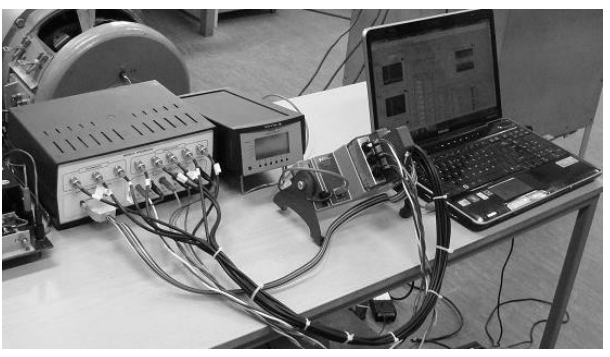
Figure 5. Modular computer subsystem used for measuring diagnostic parameters.